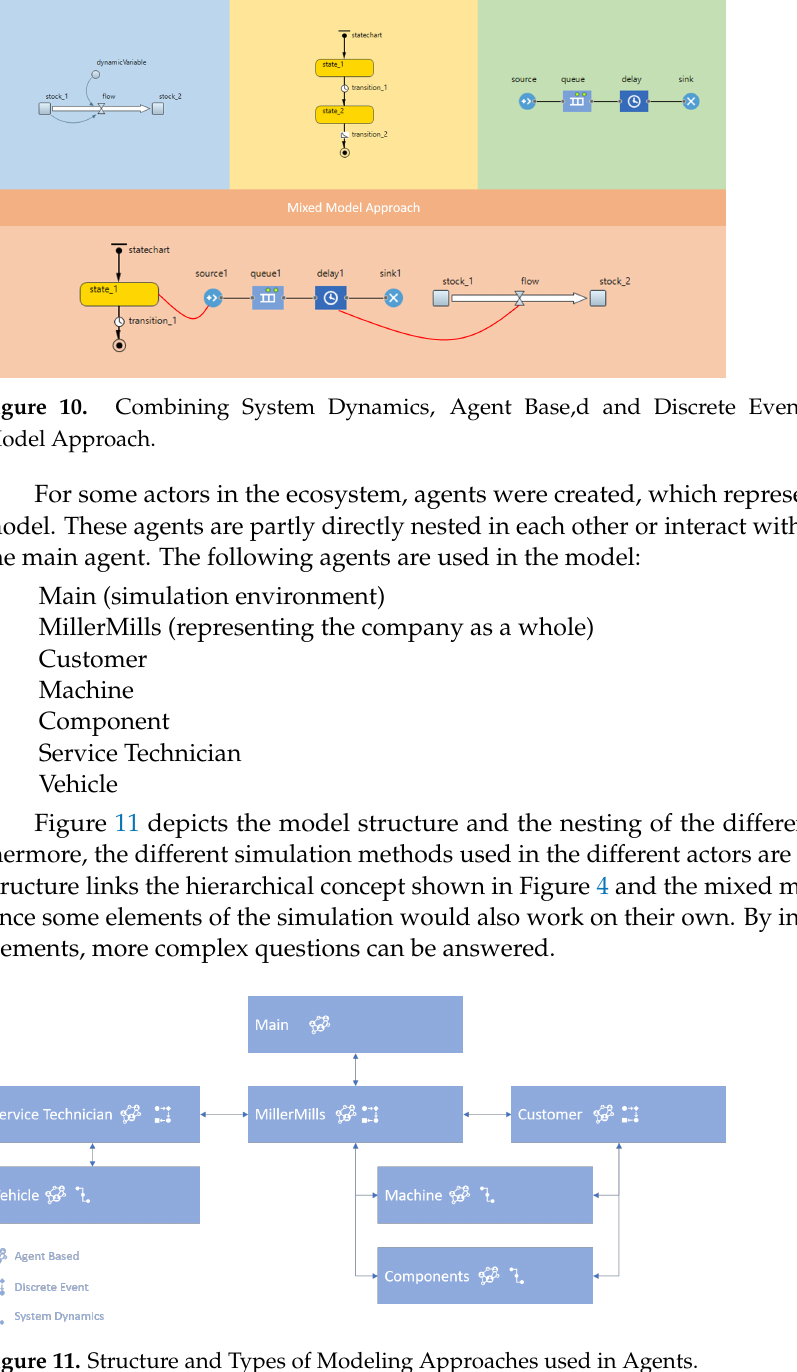
Figure 11. Structure and Types of Modeling Approaches used in